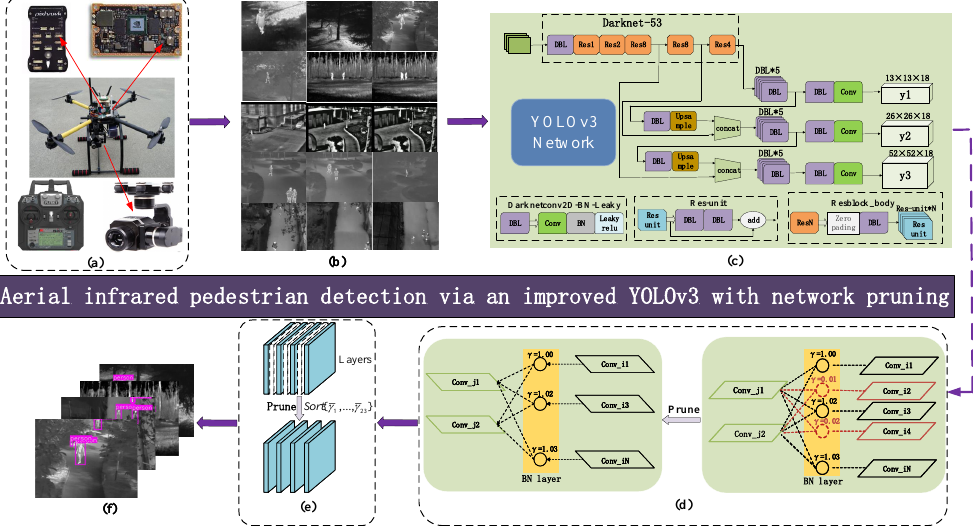
Figure 1. Overview of AIR-YOLOv3: ( a ) UAV system; ( b ) dataset construction; ( c ) fine-tuned YOLOv3 for aerial infrared pedestrian detection; ( d ) channel pruning; ( e ) layer pruning; and ( f ) test